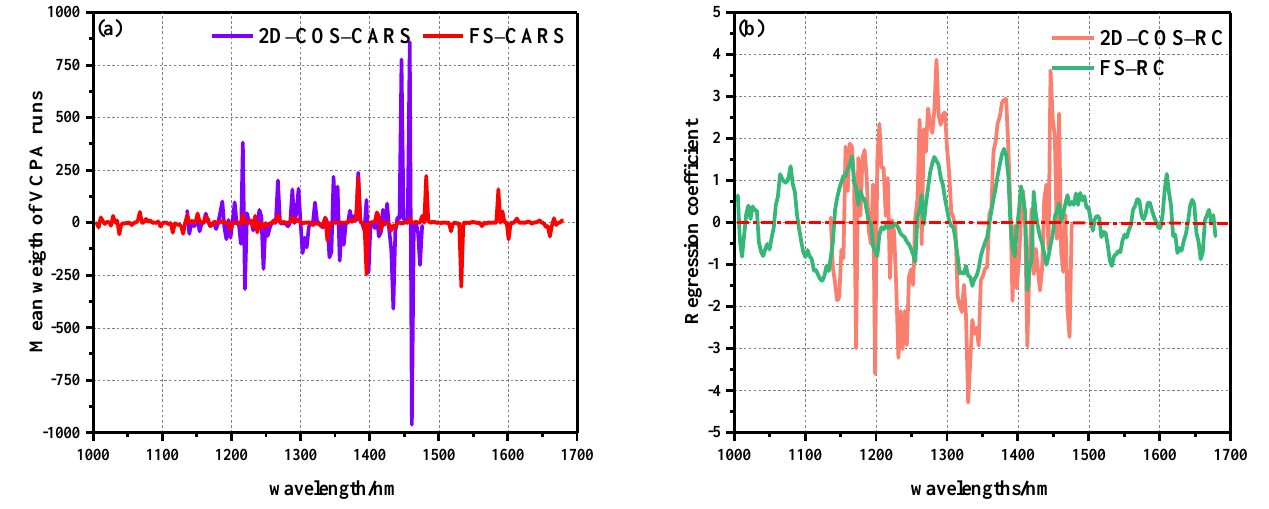
Figure 6. Operation diagram of characteristic wavelength extracted by weight algorithm: ( a ) average weight distribution diagram of CARS algorithm, ( b ) RC algorithm weight regression coefficient distribution diagram.